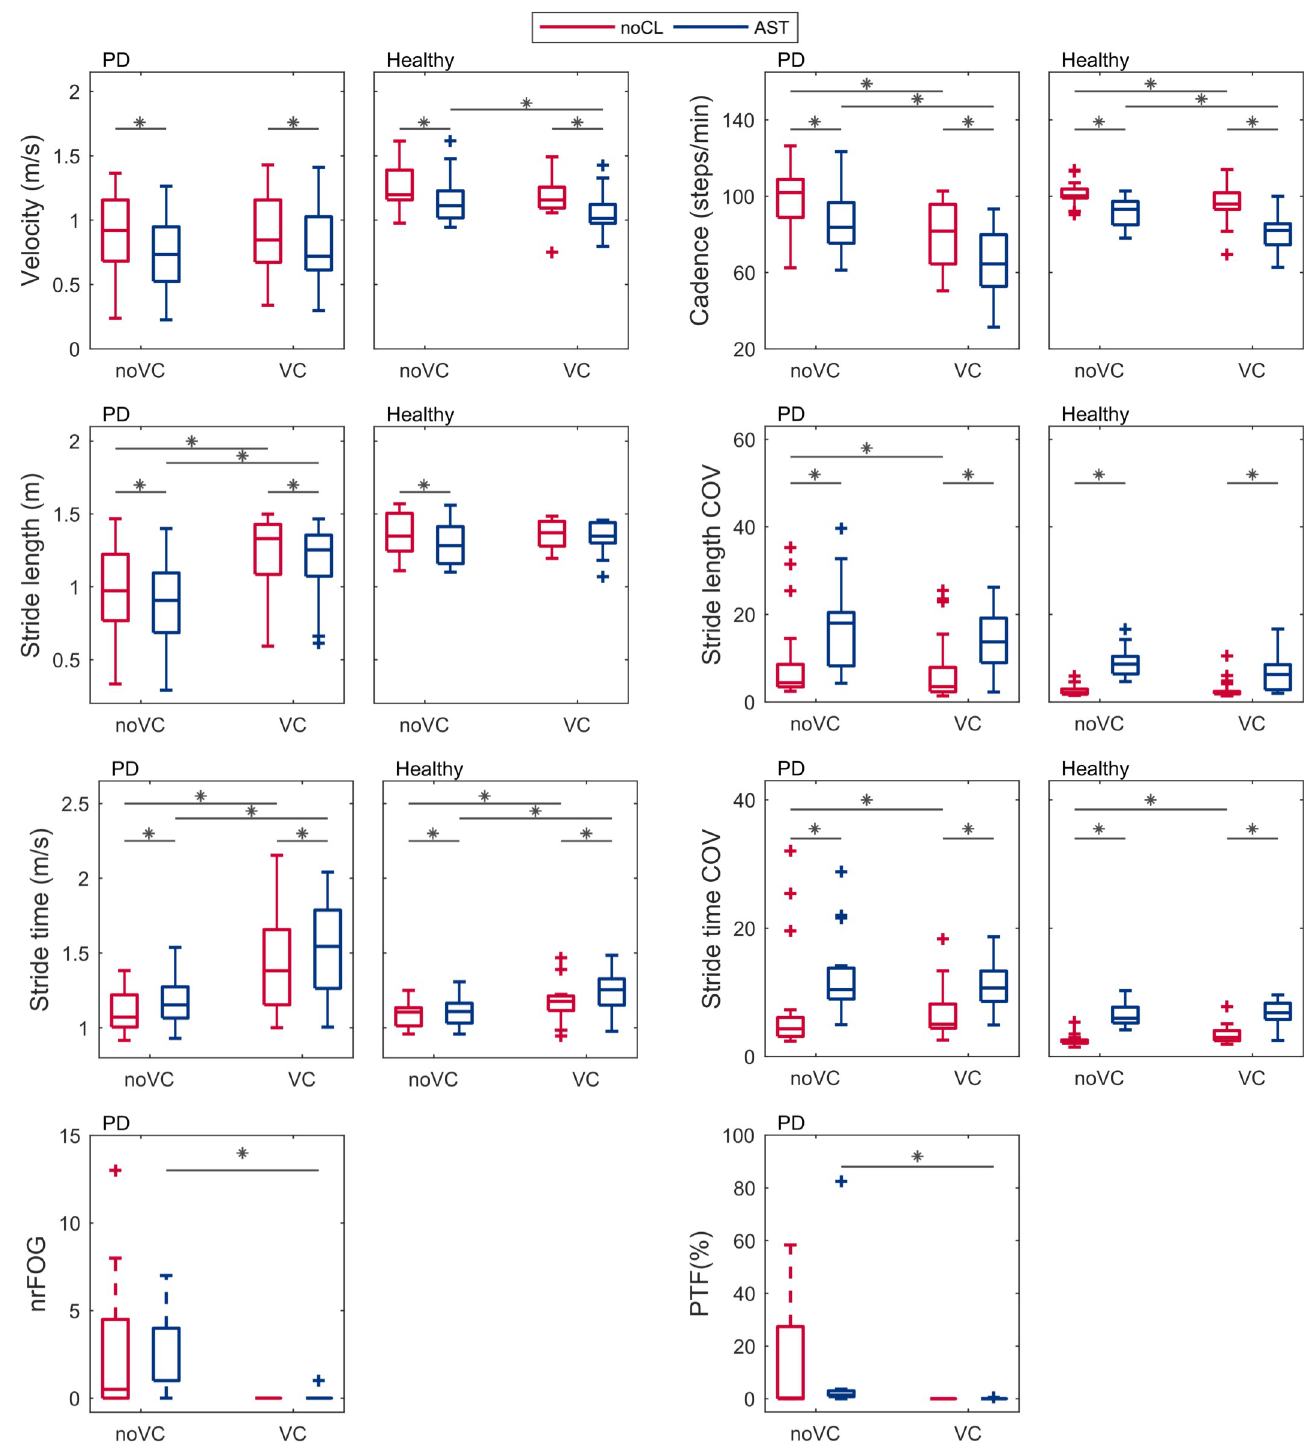
Fig 3. Gait parameters in different conditions of Experiment 2. Boxplots of the gait velocity (m/s), cadence (steps/min), stride length (m), stride length coefficient of variation (COV), stride time (sec), and stride time coefficient of variation (COV) for persons with Parkinson’s disease and freezing of gait (‘PD’) and healthy control subjects (‘Healthy’). The number of freezing of gait episodes (nrFOG) and percent time frozen (PTF) are given for PD patients. Cognitive load conditions are illustrated in red (control cognitive load, noCL), and blue (Auditory Stroop Task, AST). Conditions with no visual cues (‘noVC’) are displayed at the left sides of the plots, conditions with visual cues (‘VC’) at the right sides. Asterisks above indicate significant differences between cognitive load conditions (within the left or right half of a plot), and between visual cueing conditions (crossing the midline of the plot).